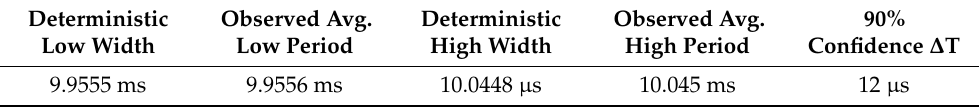
Table 2. Observed periods to external interrupts: important values.